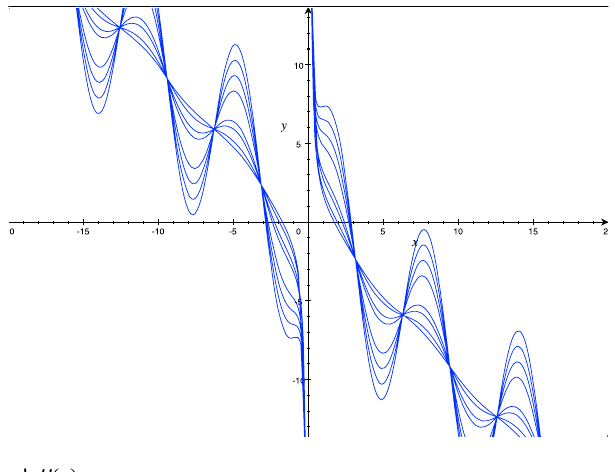
Figure 2: Close up of the graph H x ( )